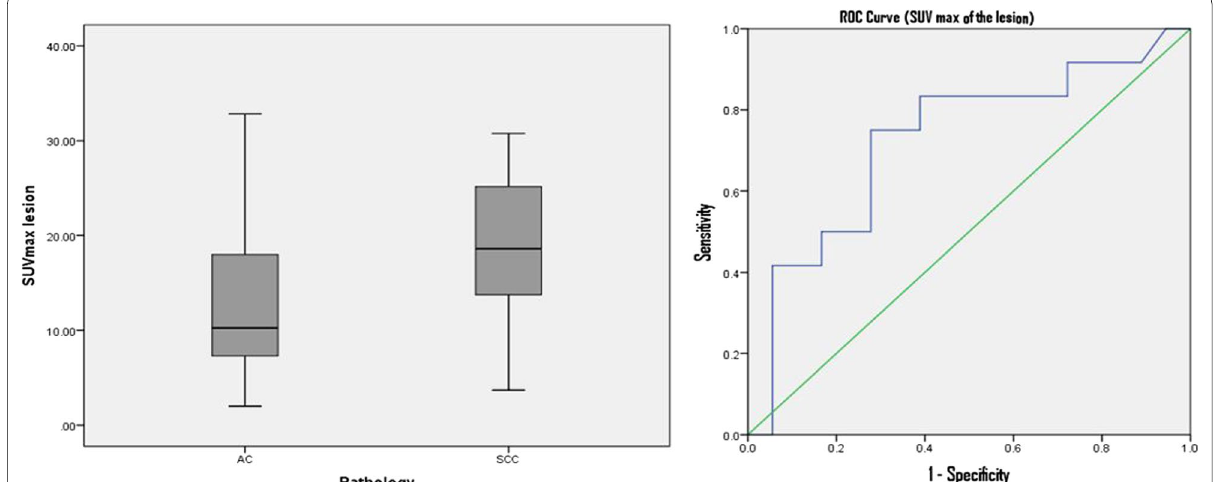
Fig. 2 Comparison of SUVmax of the lesion between AC and SCC. Also, the ROC curve of the SUV max of the lesion concerning the histopathology of the lesion